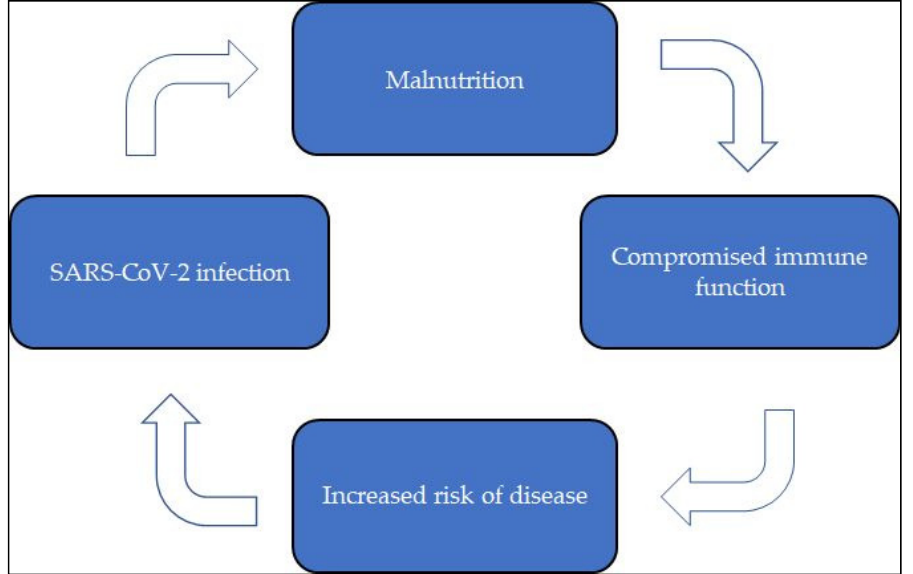
Figure 1. The vicious circle connecting malnutrition to immune system impaired activity and individual SARS-CoV-2 infection susceptibility.